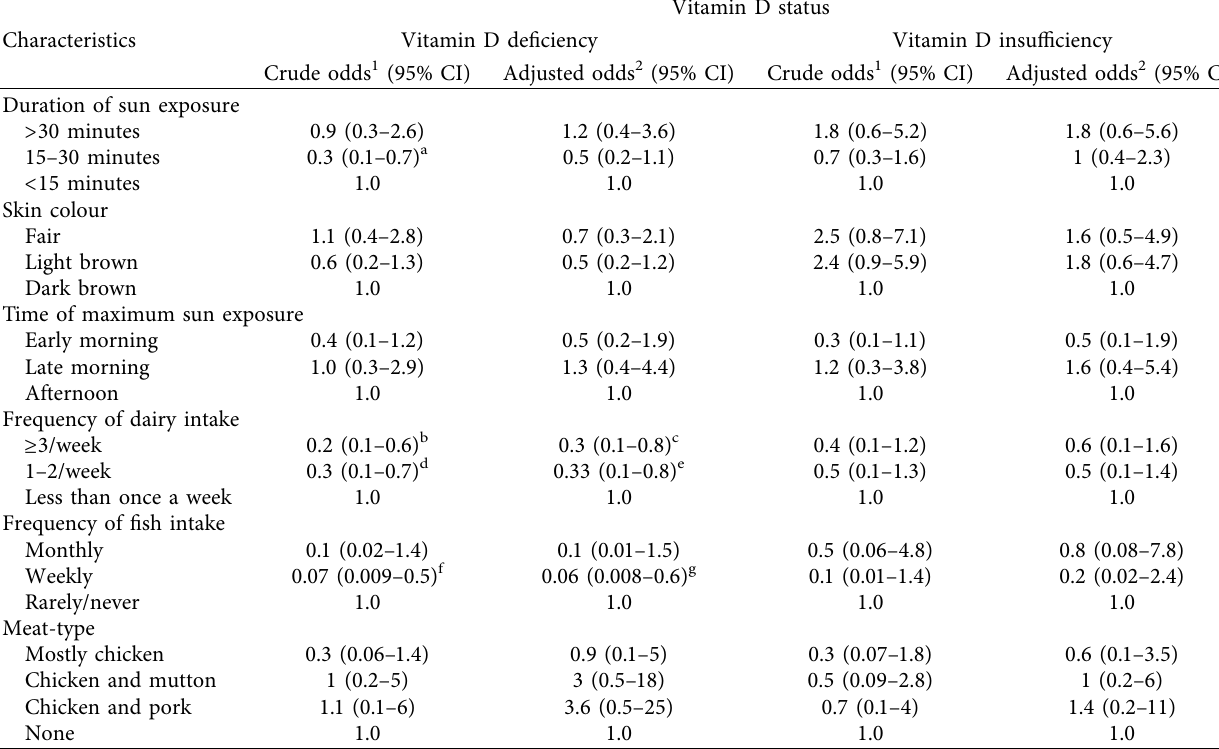
Table 3: Multivariate analysis of vitamin D deficiency and